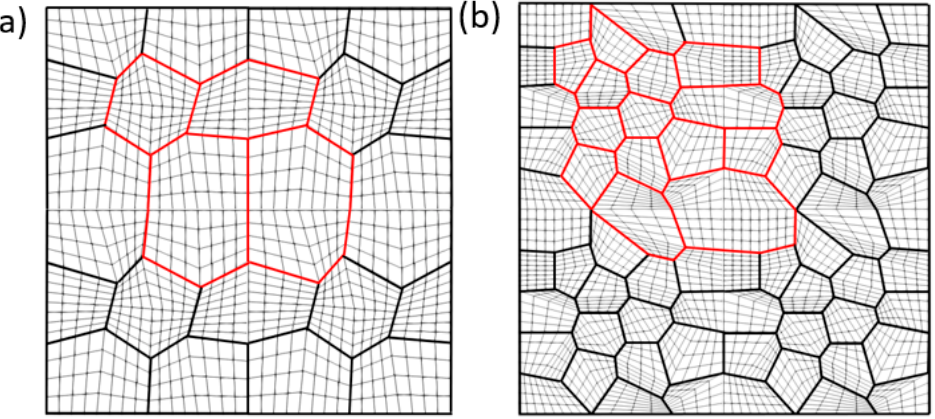
Figure 3. Finite element models of polycrystal TRIP steel with ( a ) 4-grain and ( b ) 14-grain in infinite medium [27,42].